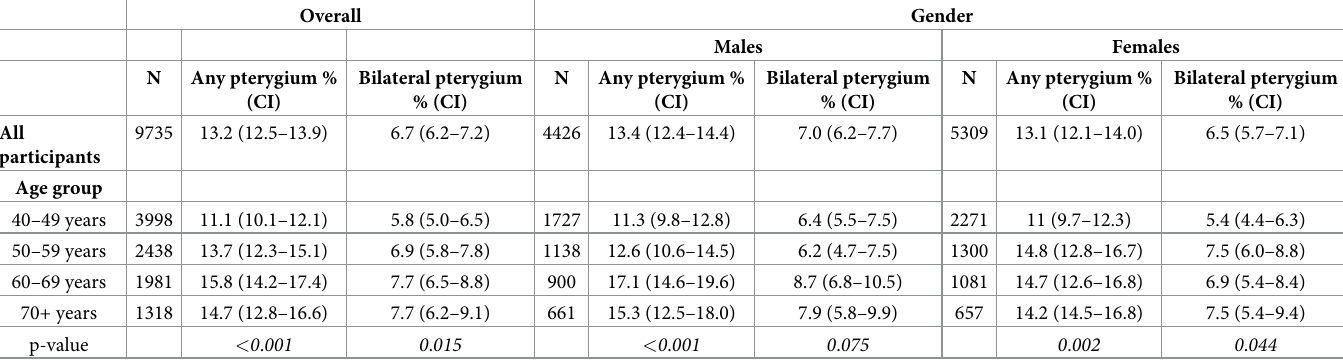
Table 1. Prevalence rates of pterygium in the study population by age and